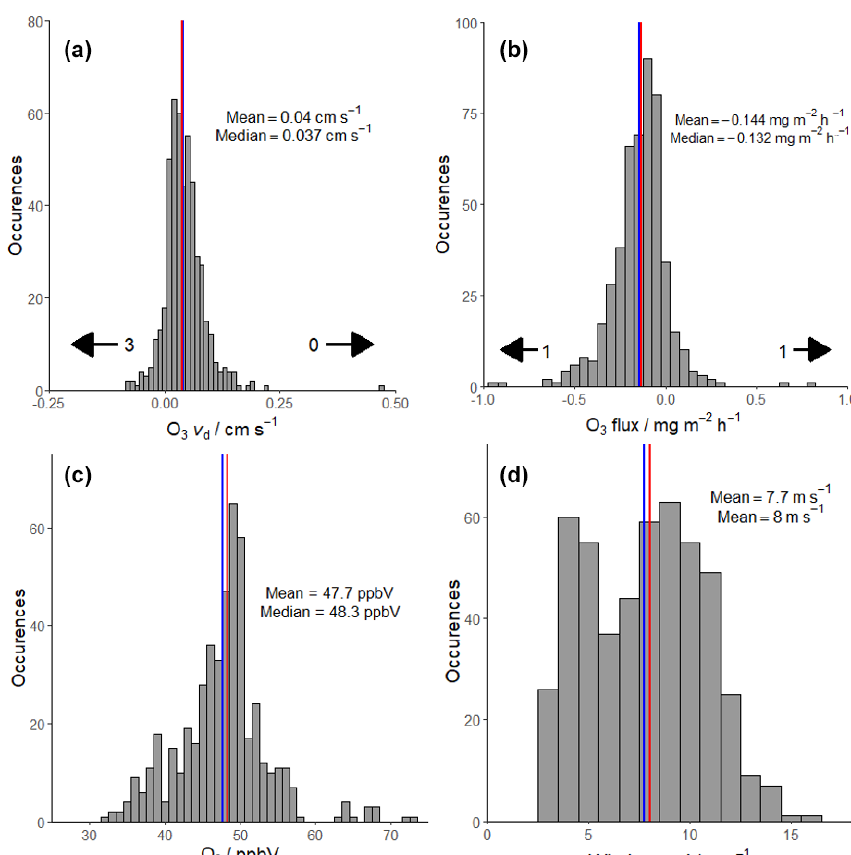
Figure 6. Ozone deposition velocity (a) , mass flux (b) , ozone concentration (c) and wind speed (d) histograms for all periods that passed the filtering criteria. Mean values are represented by blue lines and median values by red lines. Deposition velocity and mass flux are plotted in the range − 0.25–0.50cms − 1 and − 1.0–1.0mgm − 2 h − 1 respectively for clarity, with arrows indicating the number of points beyond these